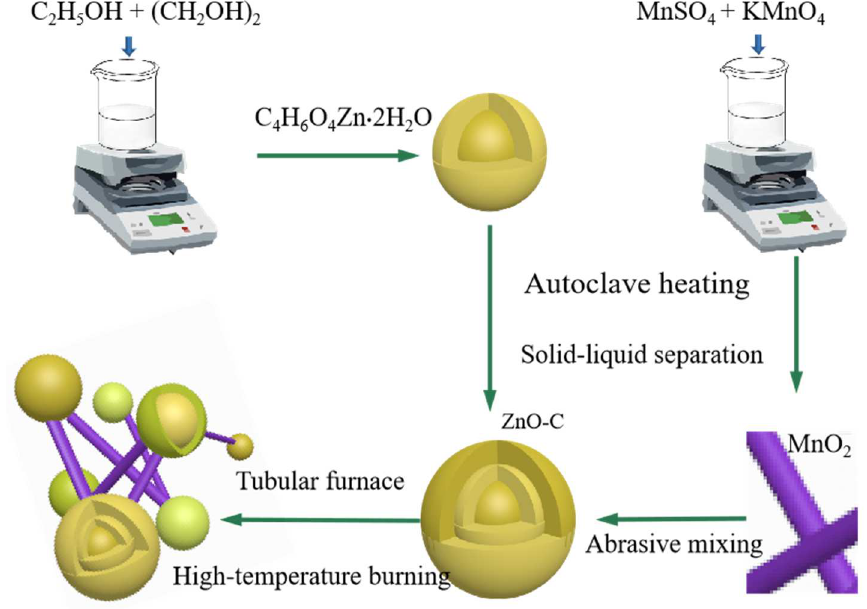
Figure 13. Flow chart of material preparation.